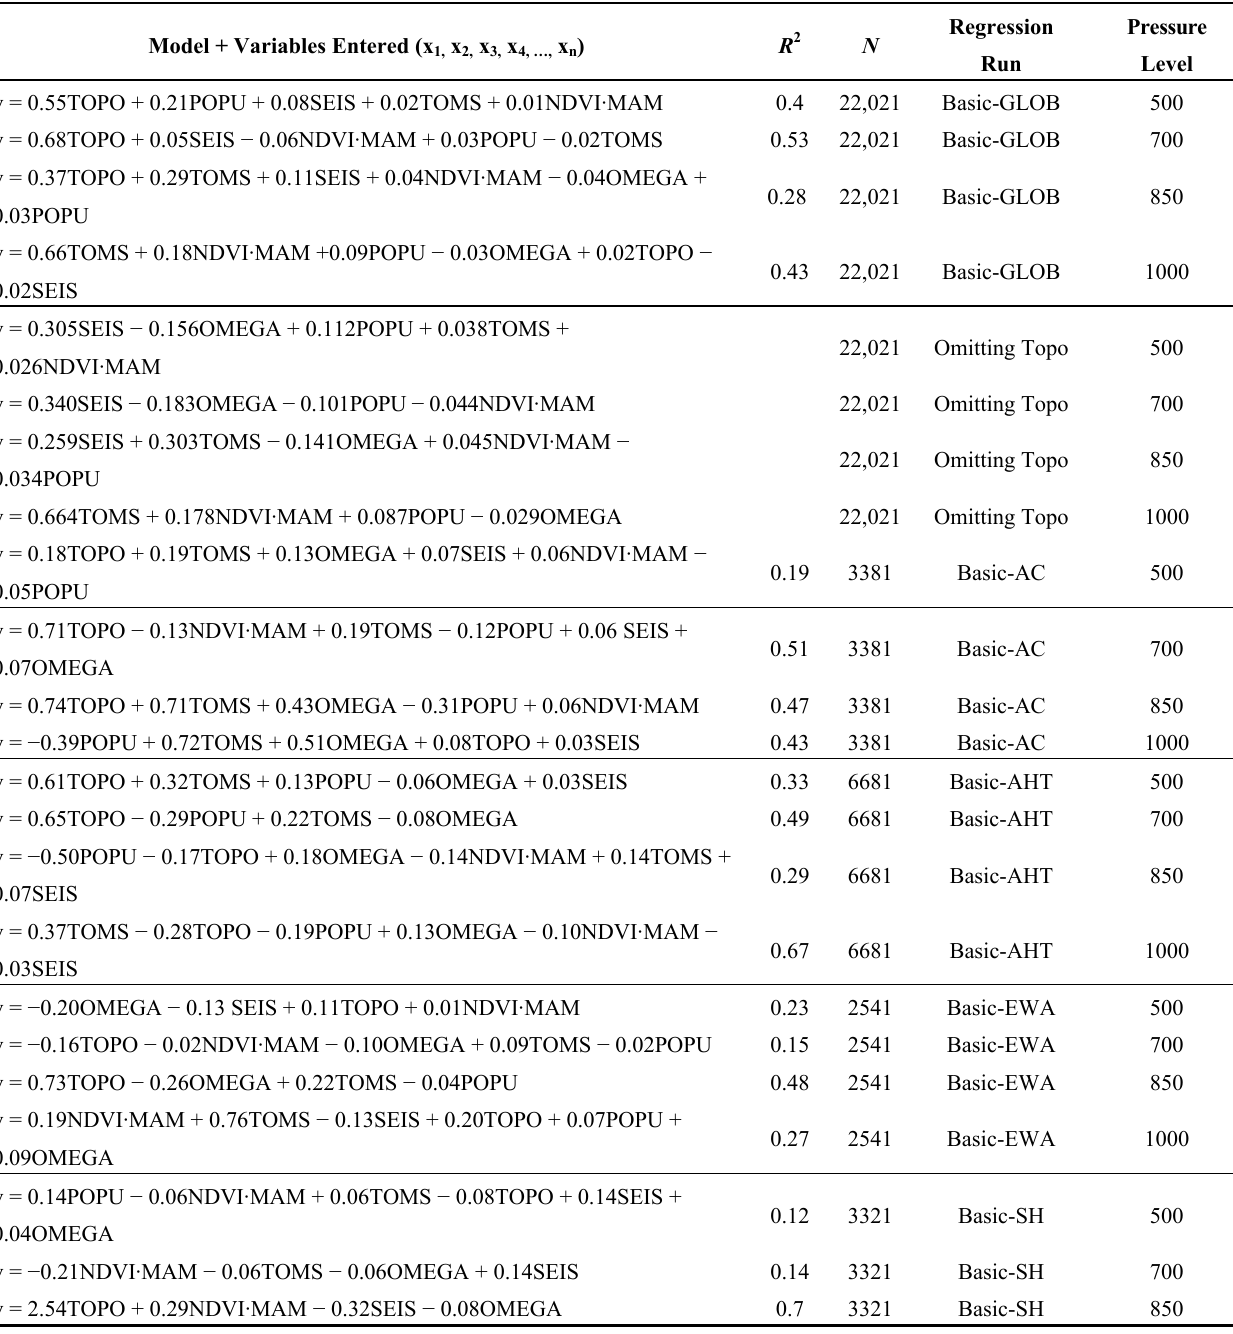
Table 2. Summary of multiple regression results of the dummy variable run, the “basic run” for the different research regions (full and subdomains) predicting Incremental Analysis Updates for the month of May (MAY-IAU) (T) (y). +: positive association; –: negative association. The variable abbreviations are described in Table 1. Predictors are given as a regression model equation in order of importance. All coefficients are significant at p < 0.05. All abbreviations are defined in Table